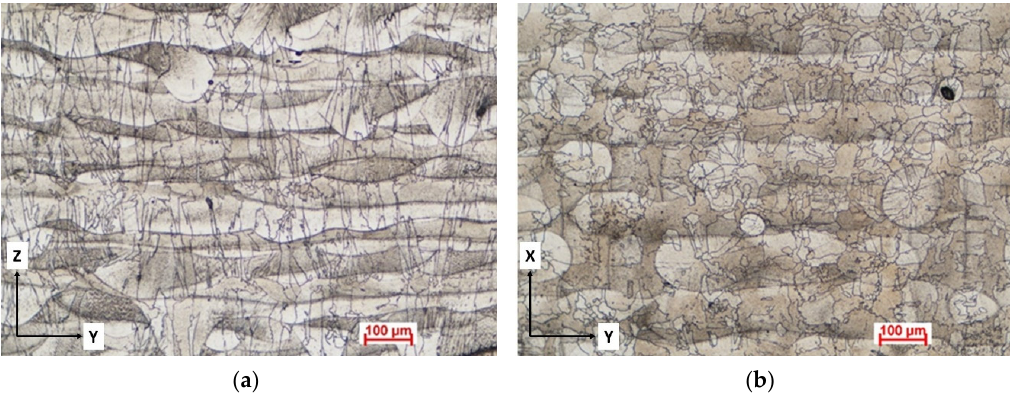
Figure 16. Stress-relieved microstructure showing the epitaxial columnar grain morphology in the YZ plane ( a ) and recrystallized grains in the XY plane ( b ). YZ plane ( a ) and recrystallized grains in the XY plane ( b